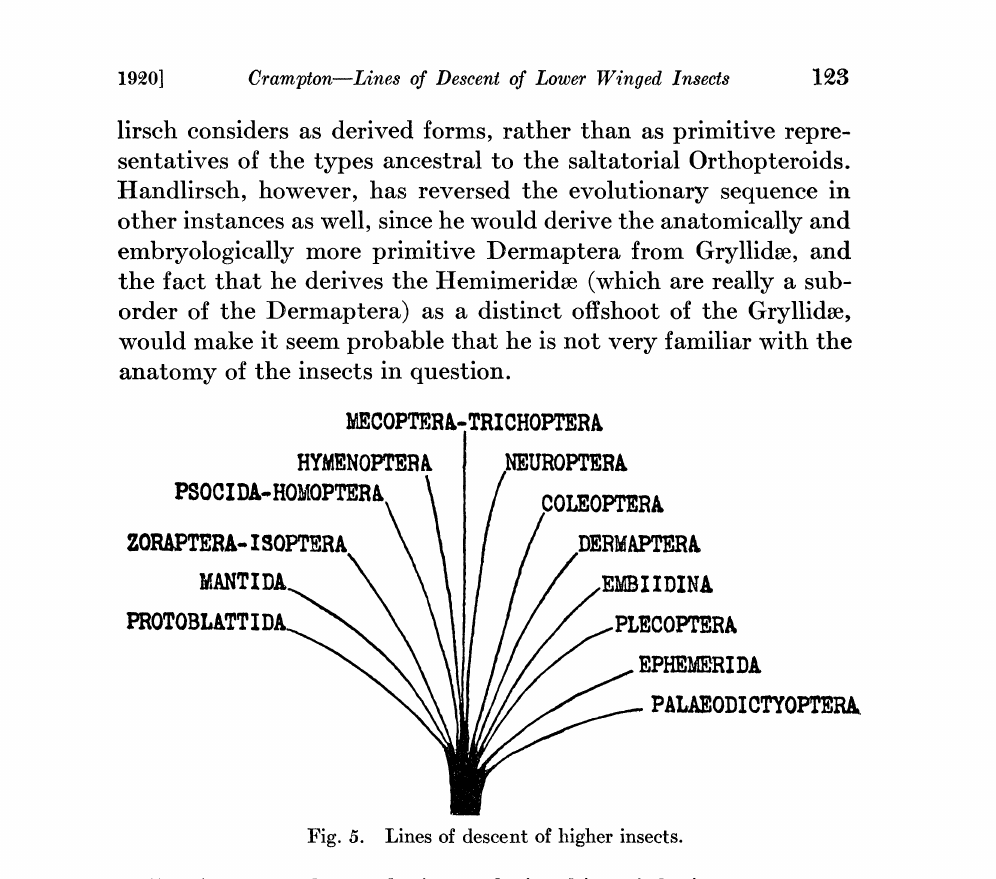
:Fig. 5. Lines of descent of higher